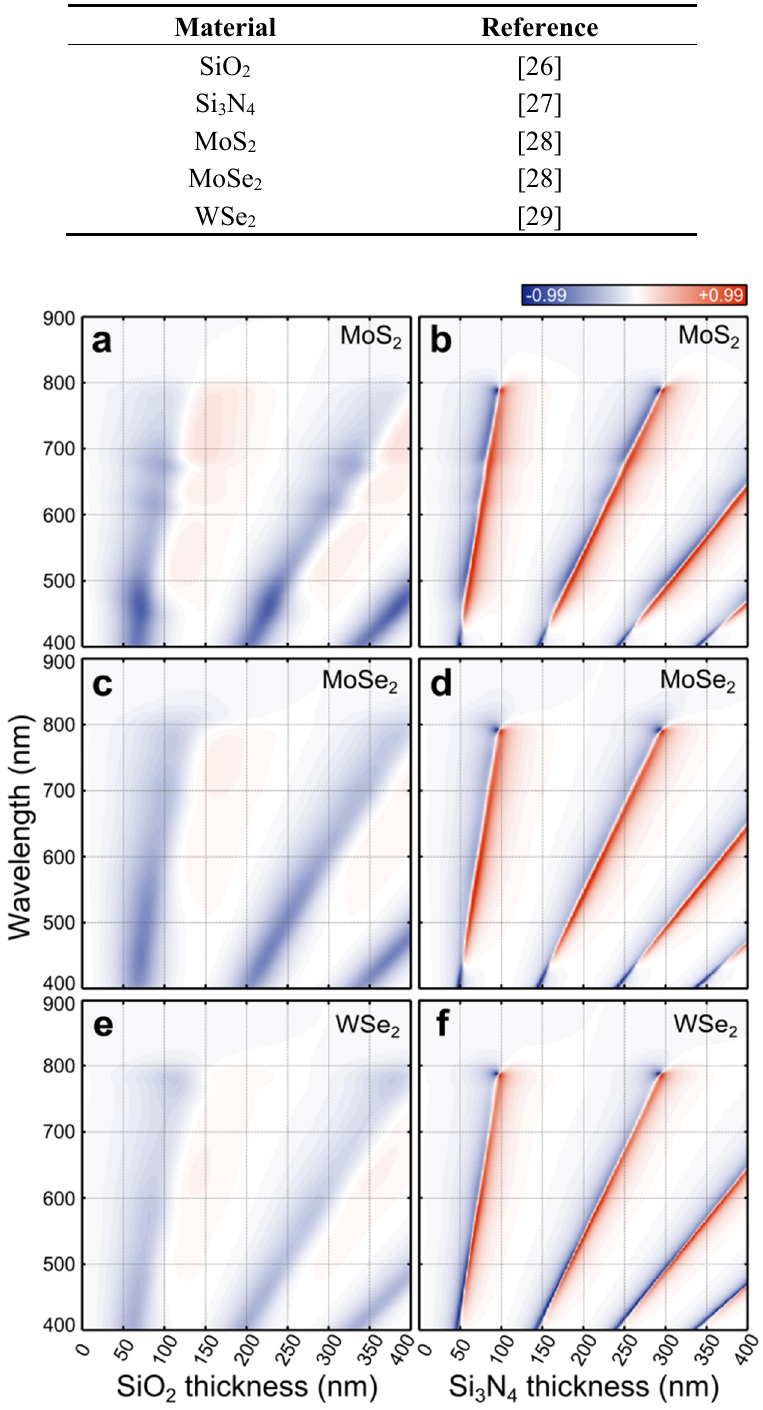
Table 1. Summary of the references with the refractive index values necessary for the calculation of the optical contrast.